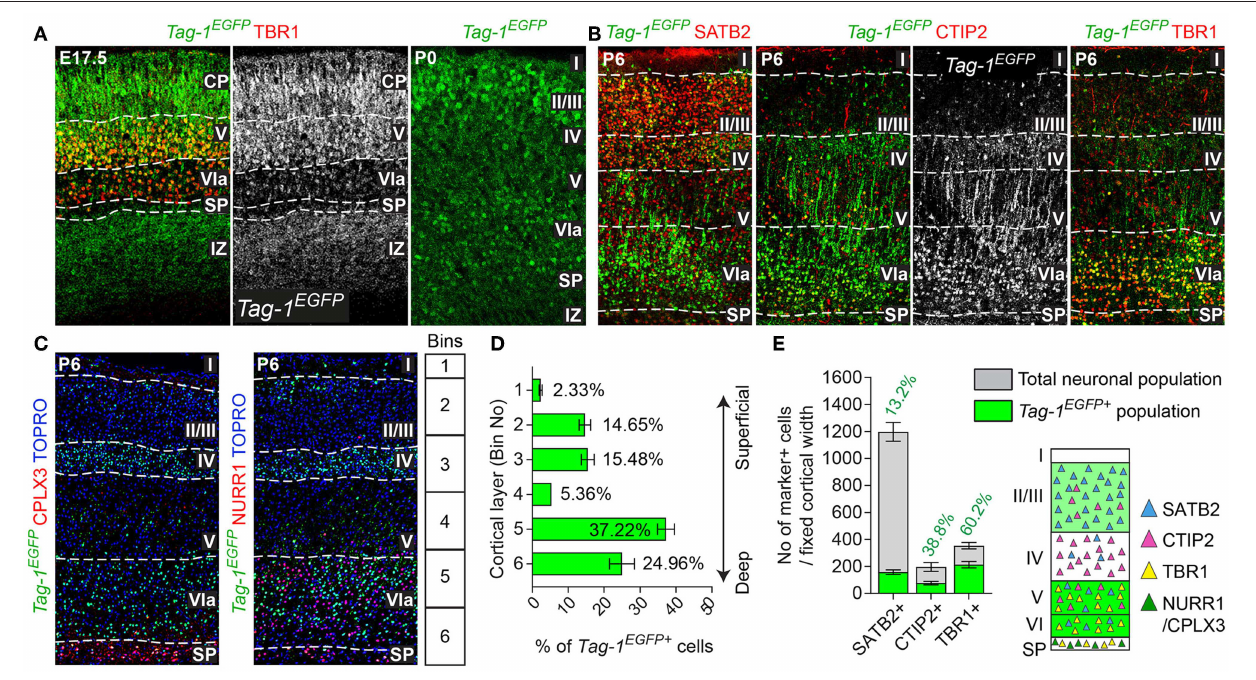
FIGURE 3 | TAG-1 + neocortical neurons contribute to a small degree to upper layers and to a greater extent to deeper cortical layers postnatally. (A) Immunofluorescent analysis of Tag-1 EGFP and TBR1 in the cortex at E17.5 and P0. Note the reduced EGFP detection in the subplate (SP). (B) Immunofluorescence showing the expression of the Tag-1 loxP − EGFP − loxP − DTA transgene in the somatosensory cortex at P6 and the layer markers SATB2, CTIP2 and TBR1. (C) Immunofluorescent analysis of Tag-1 EGFP expression in the somatosensory cortex at P6 in combination with the subplate markers NURR1 and CPLX3. (D) Tag-1 EGFP + cell distribution across cortical layers. Data are plotted as mean ± SEM, N = 4. (E) Tag-1 EGFP + contribution to the SATB2 + , CTIP2 + , and TBR1 + neuronal populations of the P6 neocortex. Data are plotted as mean ± SEM, for SATB2: N = 4, for CTIP2: N = 3, for TBR1: N = 5 and the double positive EGFP + ;marker + population is shown superimposed on the total numbers of marker + cells. The scheme is summarizing the distribution of Tag-1 EGFP + cells in the early postnatal neocortex. CP, cortical plate, SP, subplate, IZ, intermediate